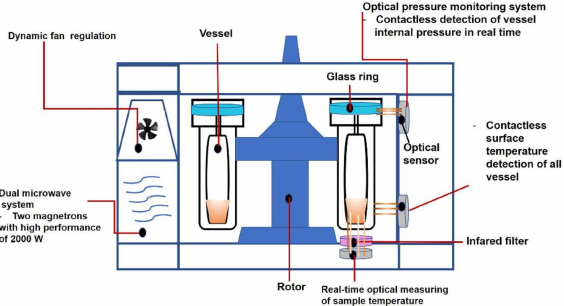
Figure 8. Microwave details of a microwave digestion system (Speedwave Xpert, Berghof Products, Eningen, Germany) adapted from a manual of Speedwave Xpert microwave